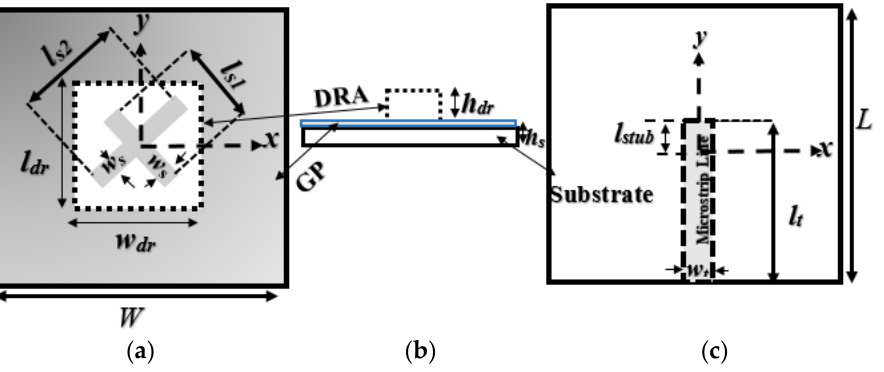
Figure 1. Antenna configuration: ( a ) top view, ( b ) front view, ( c ) back view. Table 1. Parameters of the proposed single DRA element.